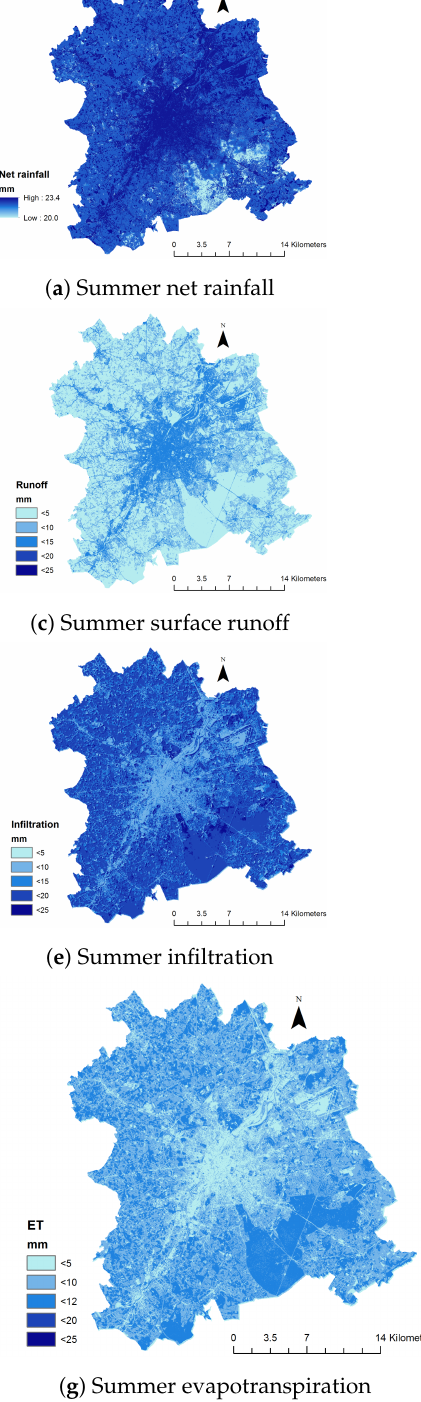
Figure 16. Water balance (20 m resolution) for an event in summer (24 mm/8 h) and winter (23 mm/41 h) in